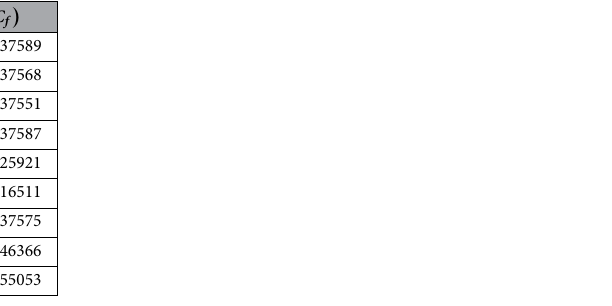
Table 1. Numerical outcomes for skin friction.